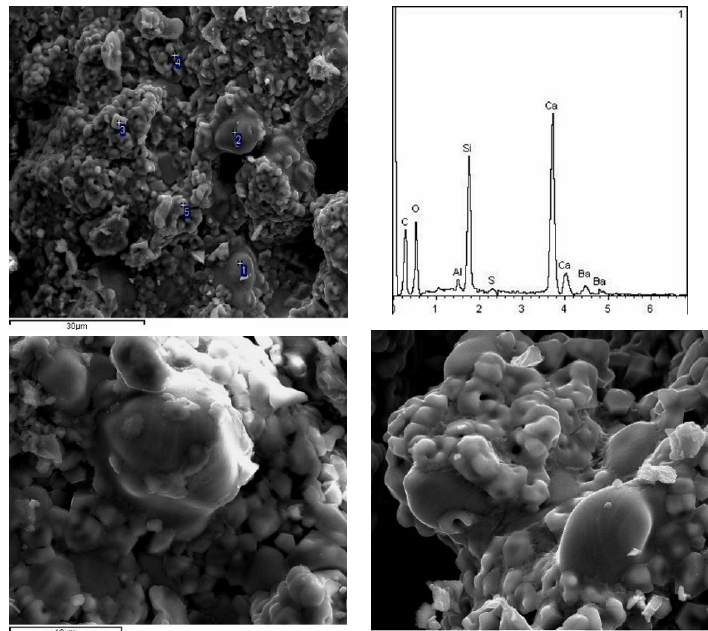
Figure 12. SEM-EDS photographs of the F1 clinker at 1300 °C .